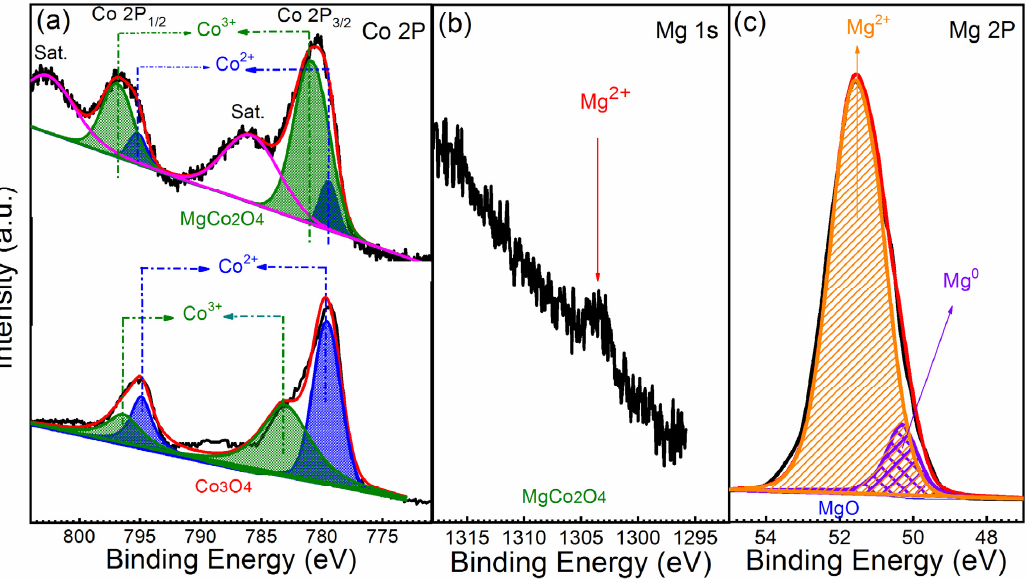
Figure 3. XPS spectra of ( a ) Co 2p, ( b ) Mg 1s, and ( c ) Mg 2P regions for the samples obtained by co-precipitation method.